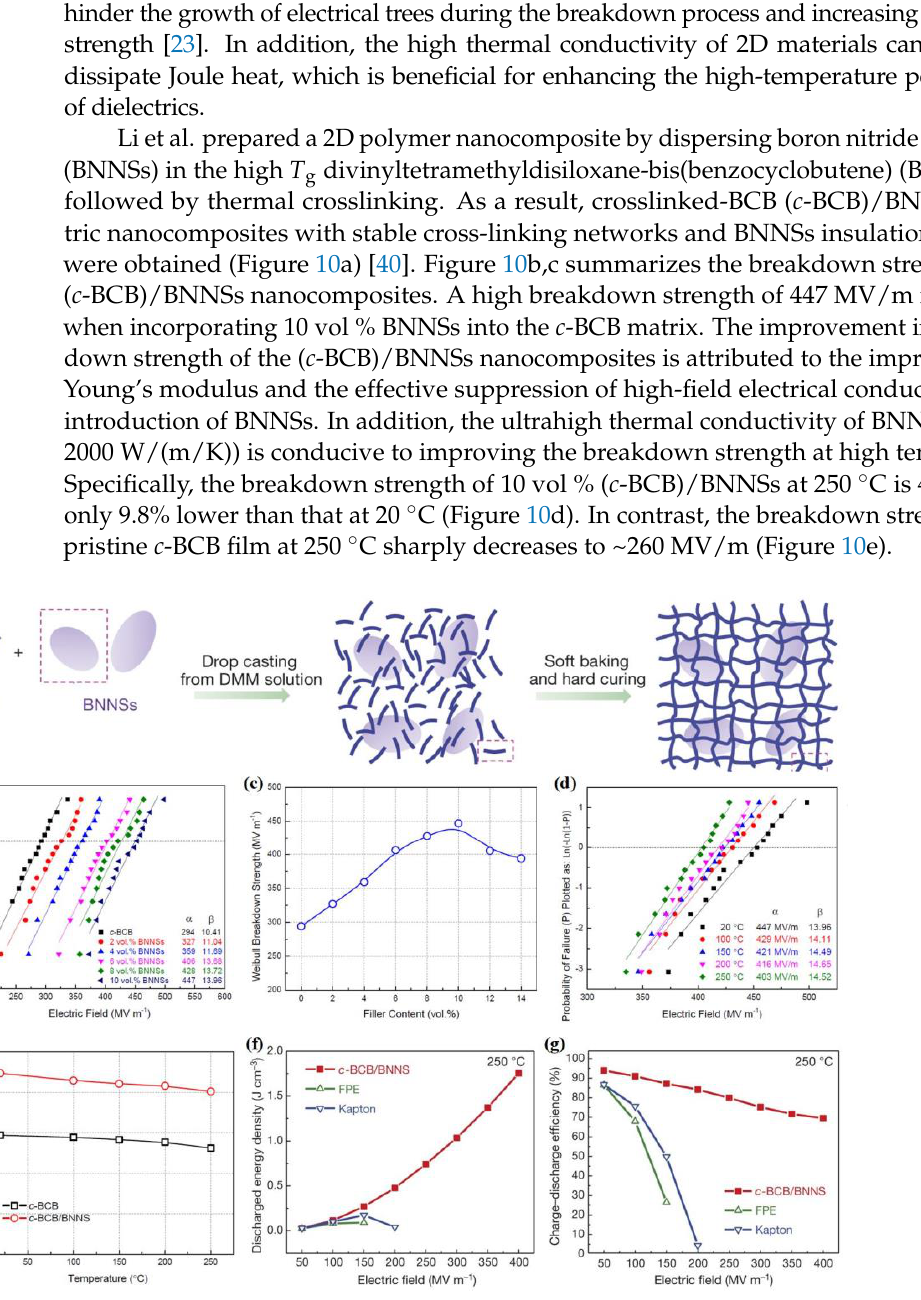
Figure 10. ( a ) Schematic of the preparation of c -BCB/BNNS films. ( b , c ) Weibull breakdown strength of c -BCB/BNNS as a function of the BNNSs content. ( d ) Weibull plots of c -BCB/BNNS with 10 vol % of BNNSs at different temperatures. ( e ) Weibull breakdown strength of c -BCB and c-BCB/BNNS as a function of temperature. The dielectric breakdown strength was measured using the electrostatic pull-down method under a direct-current voltage ramp of 500 V s − 1 . ( f , g ) Discharged energy density and efficiency of c -BCB/BNNS with 10 vol % of BNNSs at 250 °C (Measured at a frequency of 10 Hz). Reproduced with permission from Ref. [40]. Copyright 2015, Springer Nature.